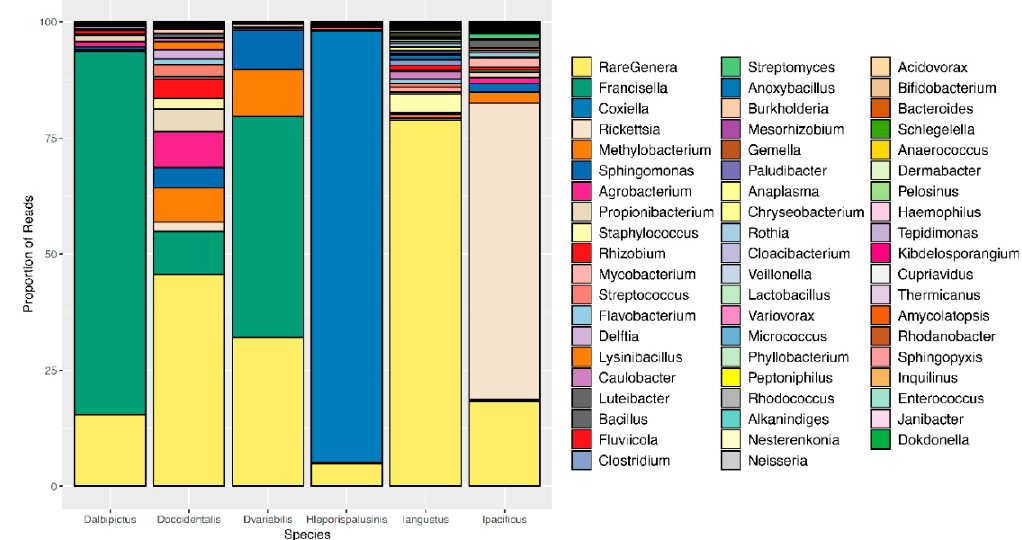
Figure 1. Microbiome composition by tick species. A representative, or averaged, microbiome is shown for each tick species with all life stages included. Colors represent OTUs at the genus level, and bar heights correspond to OTU relative abundance as determined by the percentage of sequence reads. Table 1. The core microbiome members for each tick species.